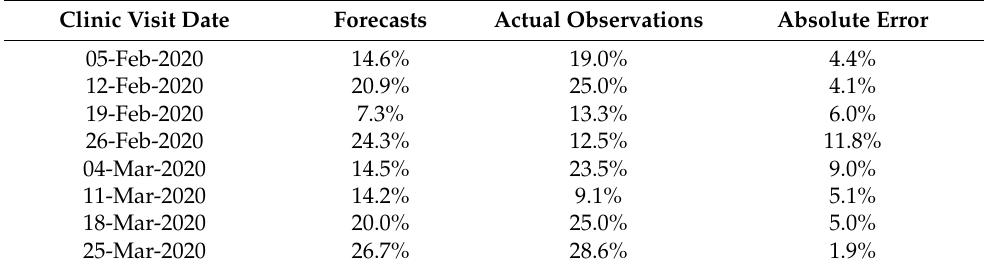
Table 3. Forecasted and actual percentage of high symptom complexity